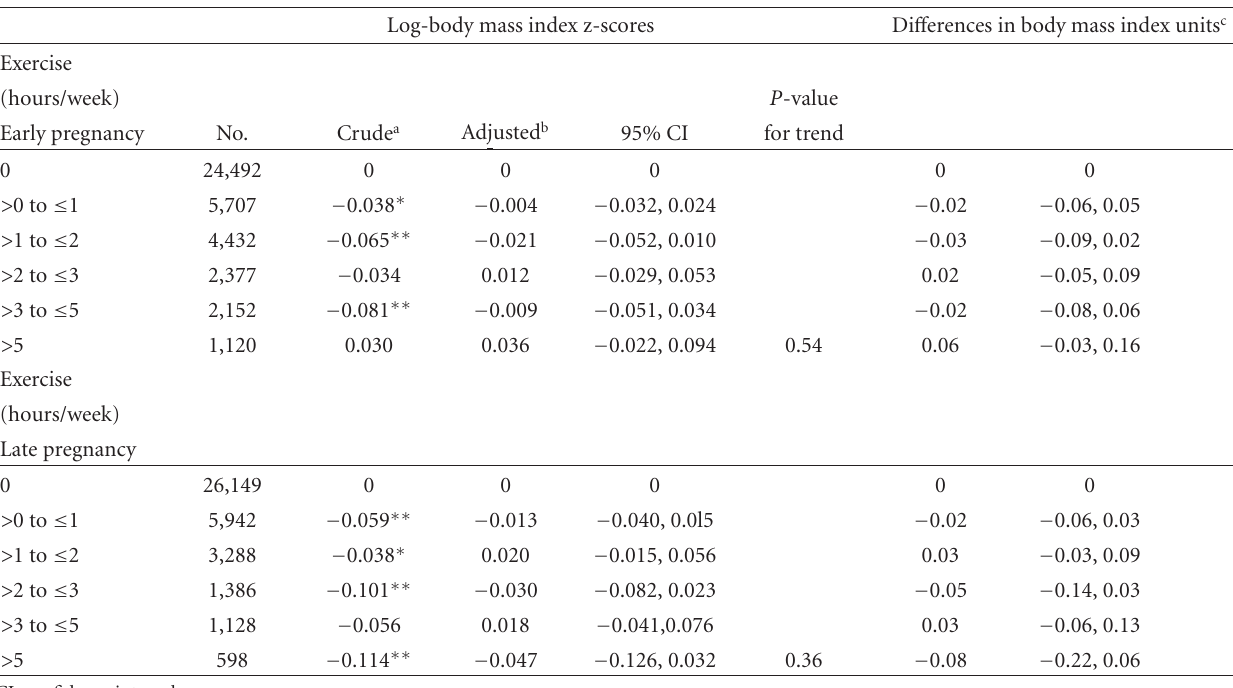
Table 2: Associations between maternal recreational exercise during pregnancy and the children’s, body mass index at 7 years of age ( z